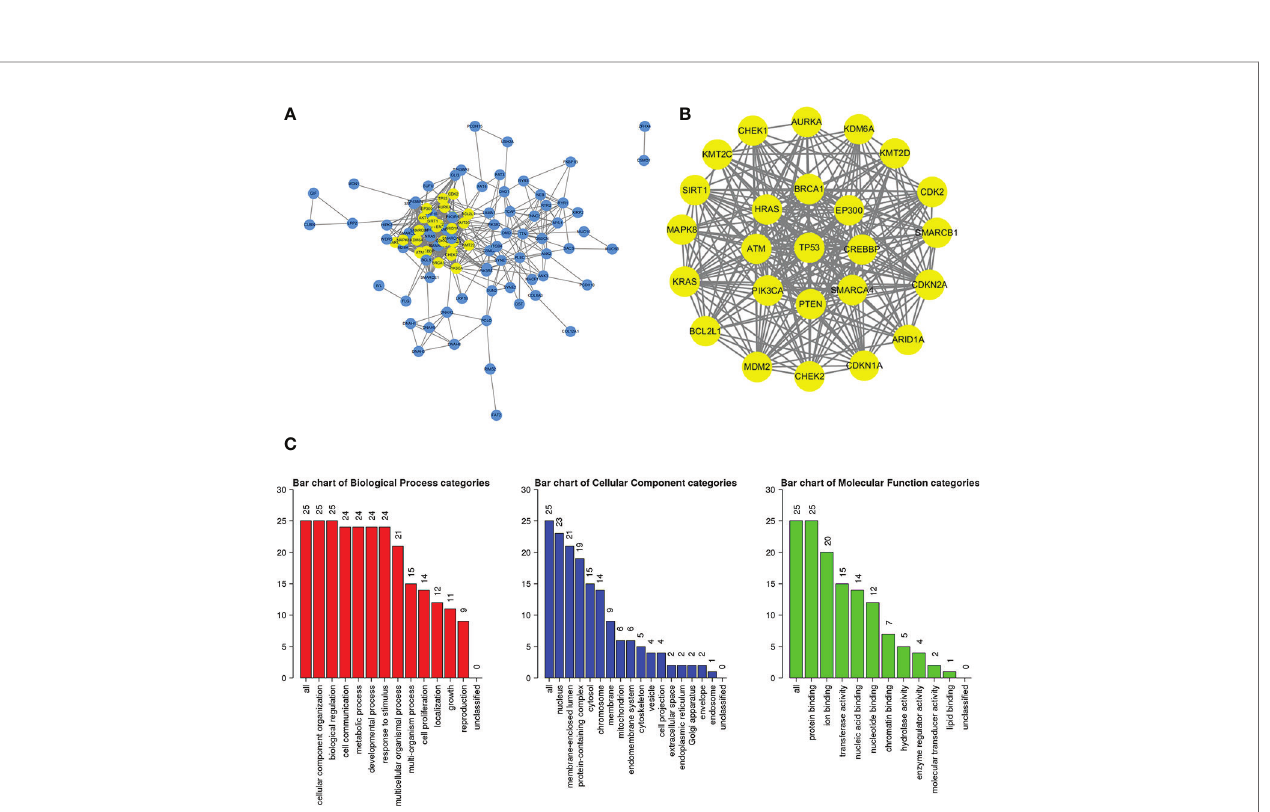
FIGURE 4 | Construction of the PPI network for the mutated genes and analysis of important modules. (A) Cytoscape was used to construct a PPI network of 945 mutant genes, including 360 nodes and 1616 edges. (B) MCODE was used to obtain an important module with 25 nodes and 245 edges from the PPI network. (C) The functional enrichment histogram of important modules. Each biological process, cellular component and molecular function category is represented by a red, blue and green bar, respectively. The height represents the number of IDs in the user list and in the